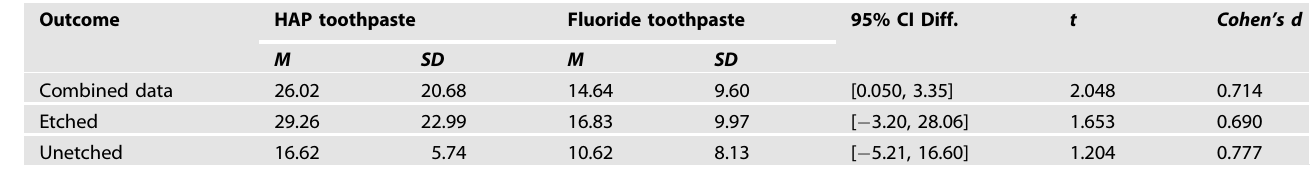
Table 4. Comparing the ef fi cacy of hydroxyapatite (HAP) toothpaste and fl uoride toothpaste on MIH lesion remineralization using percentage remineralization achieved with each